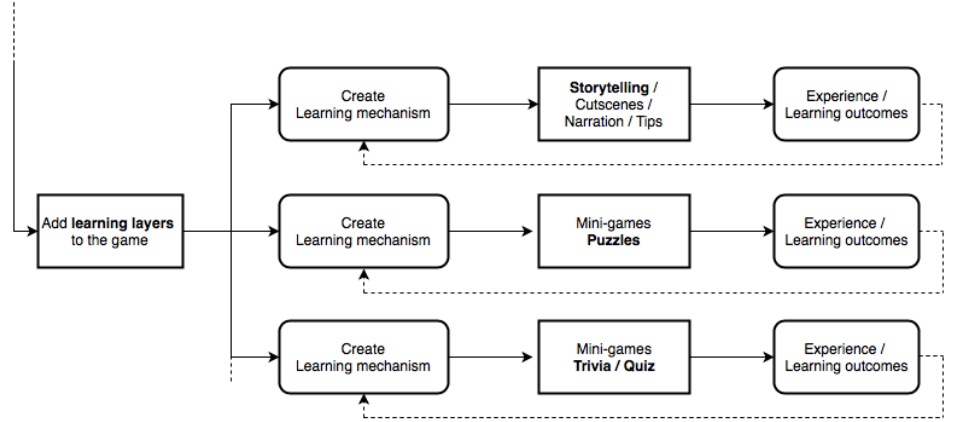
Figure 2. Learning layers that could be added to main